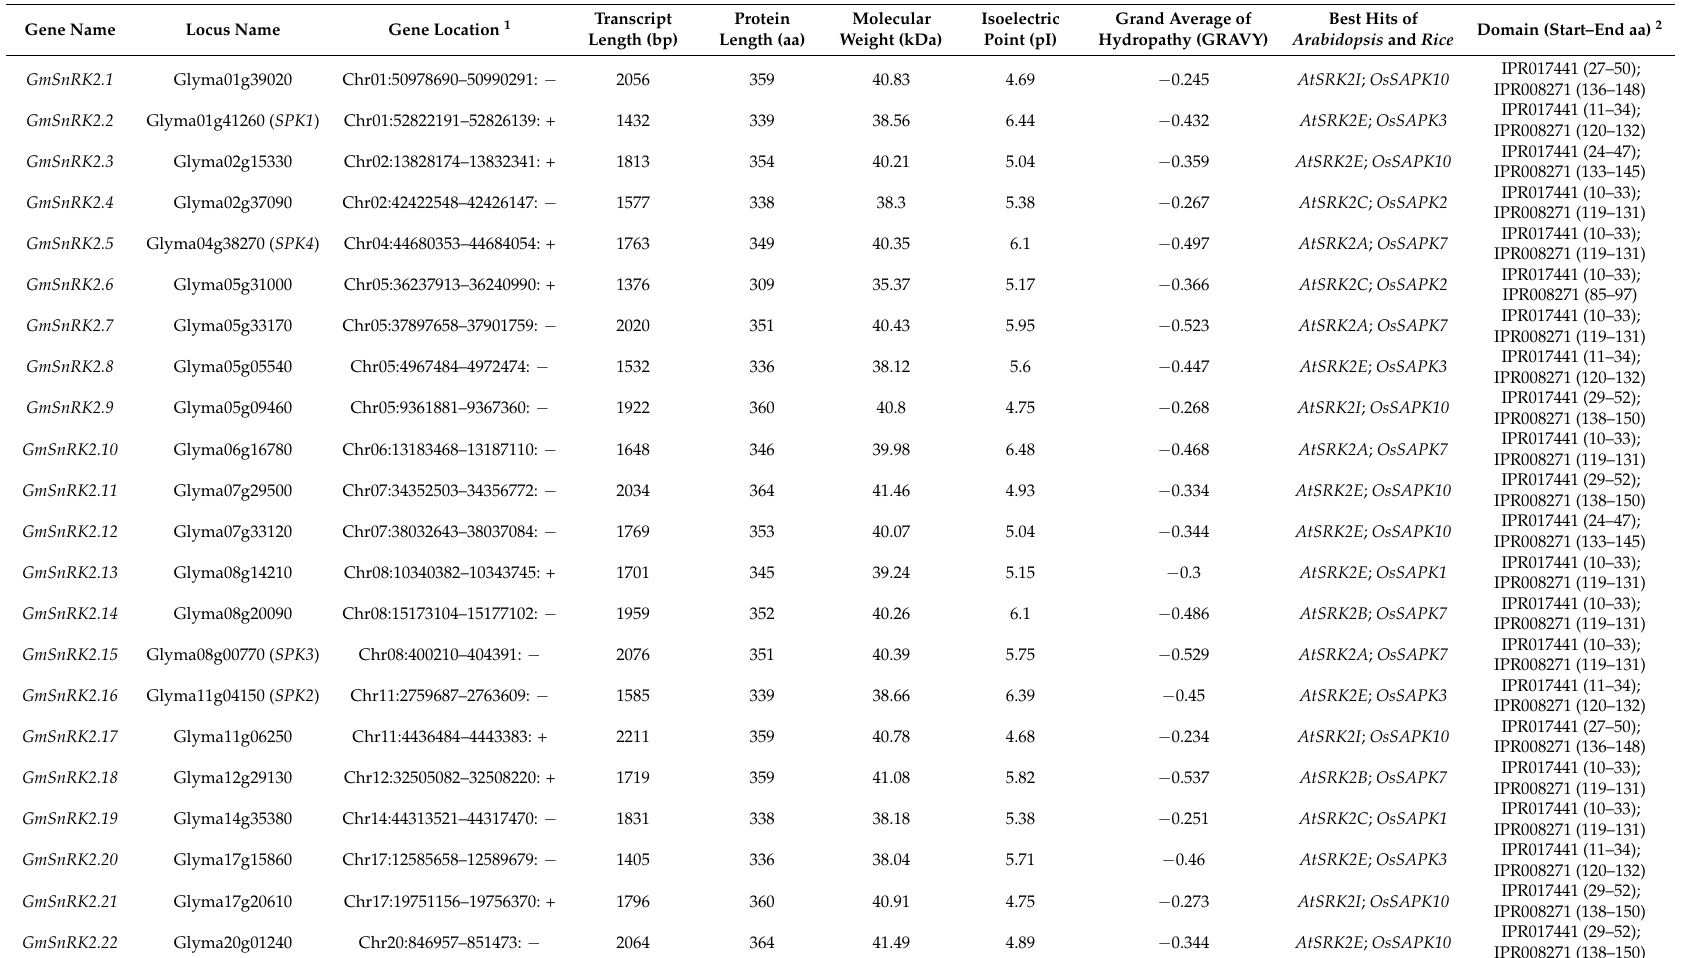
Table 1. Soybean SnRK2 gene